Question: Produce a descriptive caption suitable for publication.
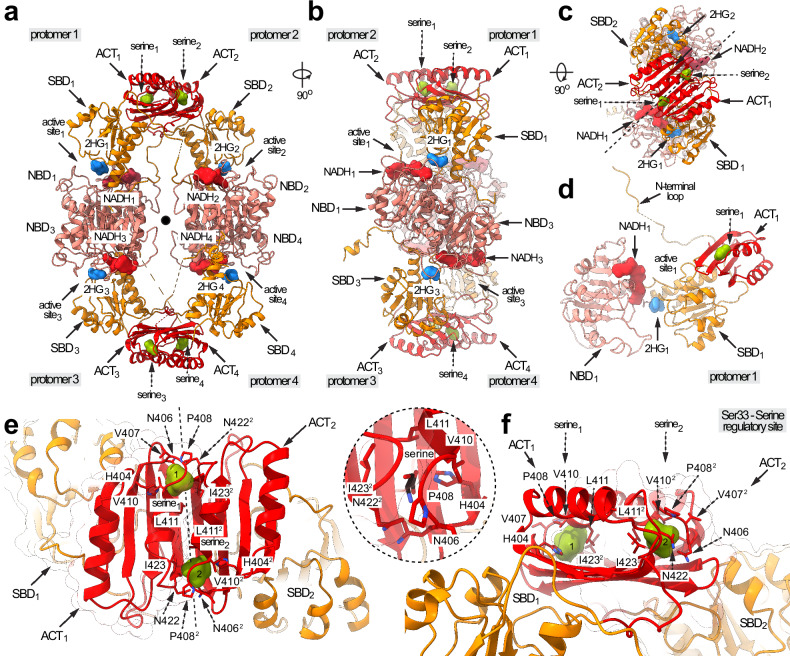
Answer: The regulatory site of Ser33. a – c The overall structure of the Ser33 homotetramer in complex with NADH, 2HG, and the allosteric regulator serine. All protomers are shown in cartoon representation, including the NBD domains (salmon), the SBD domains (orange), and the ACT regulatory domains (red). The NADH, 2HG, and serine ligands are shown in surface representation (red, blue and green, respectively). The solid circle corresponds to a 2-fold axis. d Close-up view of the Ser33 protomer active site, showing the location of NADH, 2HG, and serine. e , f Close-up view of the Ser33 regulatory sites in the Ser33-NADH-2HG-SER complex (PDB code 8Q2I ), showing the location of serine (green).